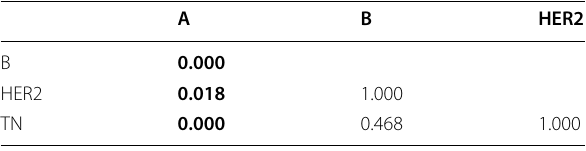
Table 5 Pairwise comparison of ADC regarding molecular type